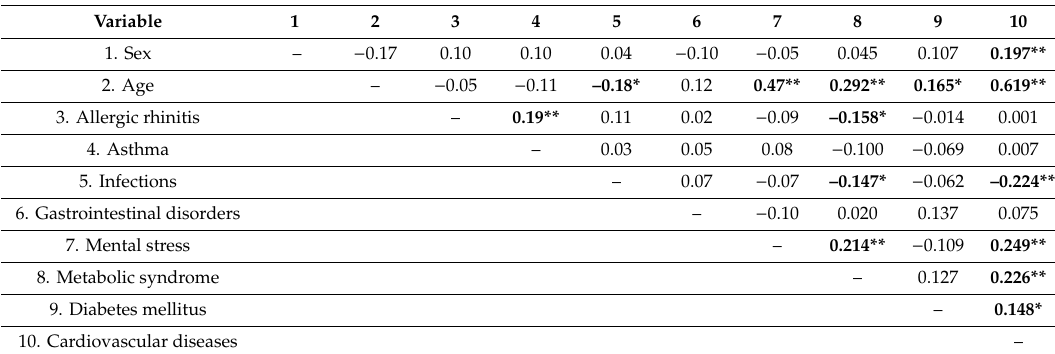
Table 6. Correlation analysis of the variables of sex, age, and comorbid diseases in patients with atopic dermatitis.